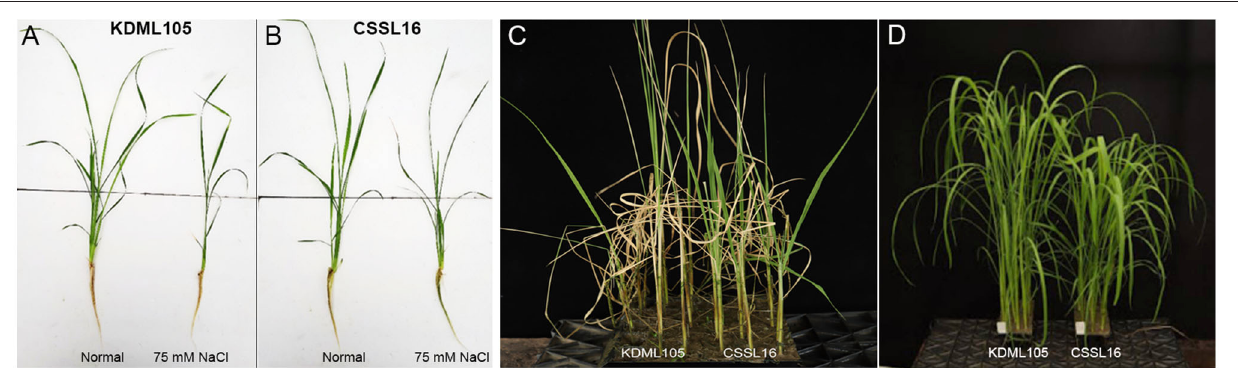
FIGURE 8 | Fourteen day-old KDML105 and CSSL16 seedlings after growing in nutrient solution in nomral condition or supplementaed with 75mM NaCl for 6 days (A,B) and the seedlings that were soil-grown and treated with 75mM for 12 days (C) or grown in normal condition (D)